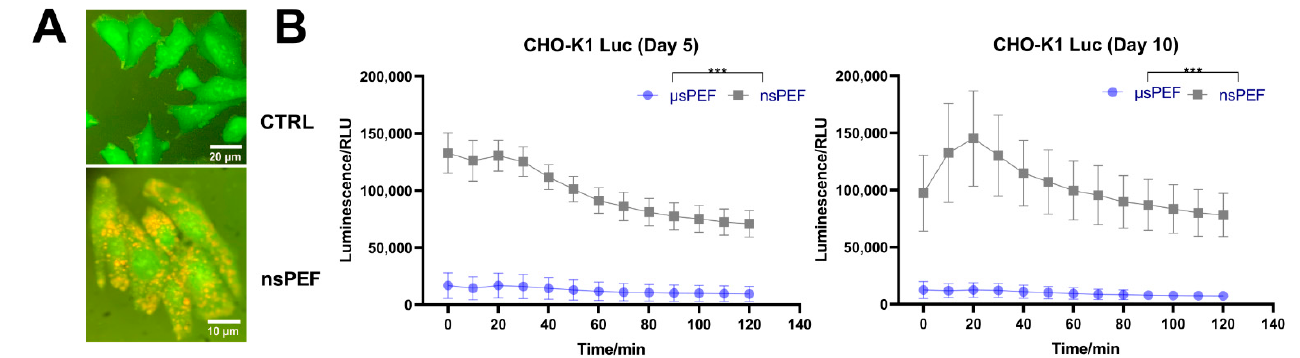
Figure 7. ( A ) Transfected CHO-K1 cells expressing tdTomato protein visualized using fluorescence microscopy ( × 40 (CTRL) and × 100 (nsPEF; immersion)). ( B ) Bioluminescent changes in selected CHO-K1 cell line clones 5- and 10-days post-cloning. Asterisk (***) corresponds to statistically significant ( p < 0.001) difference.